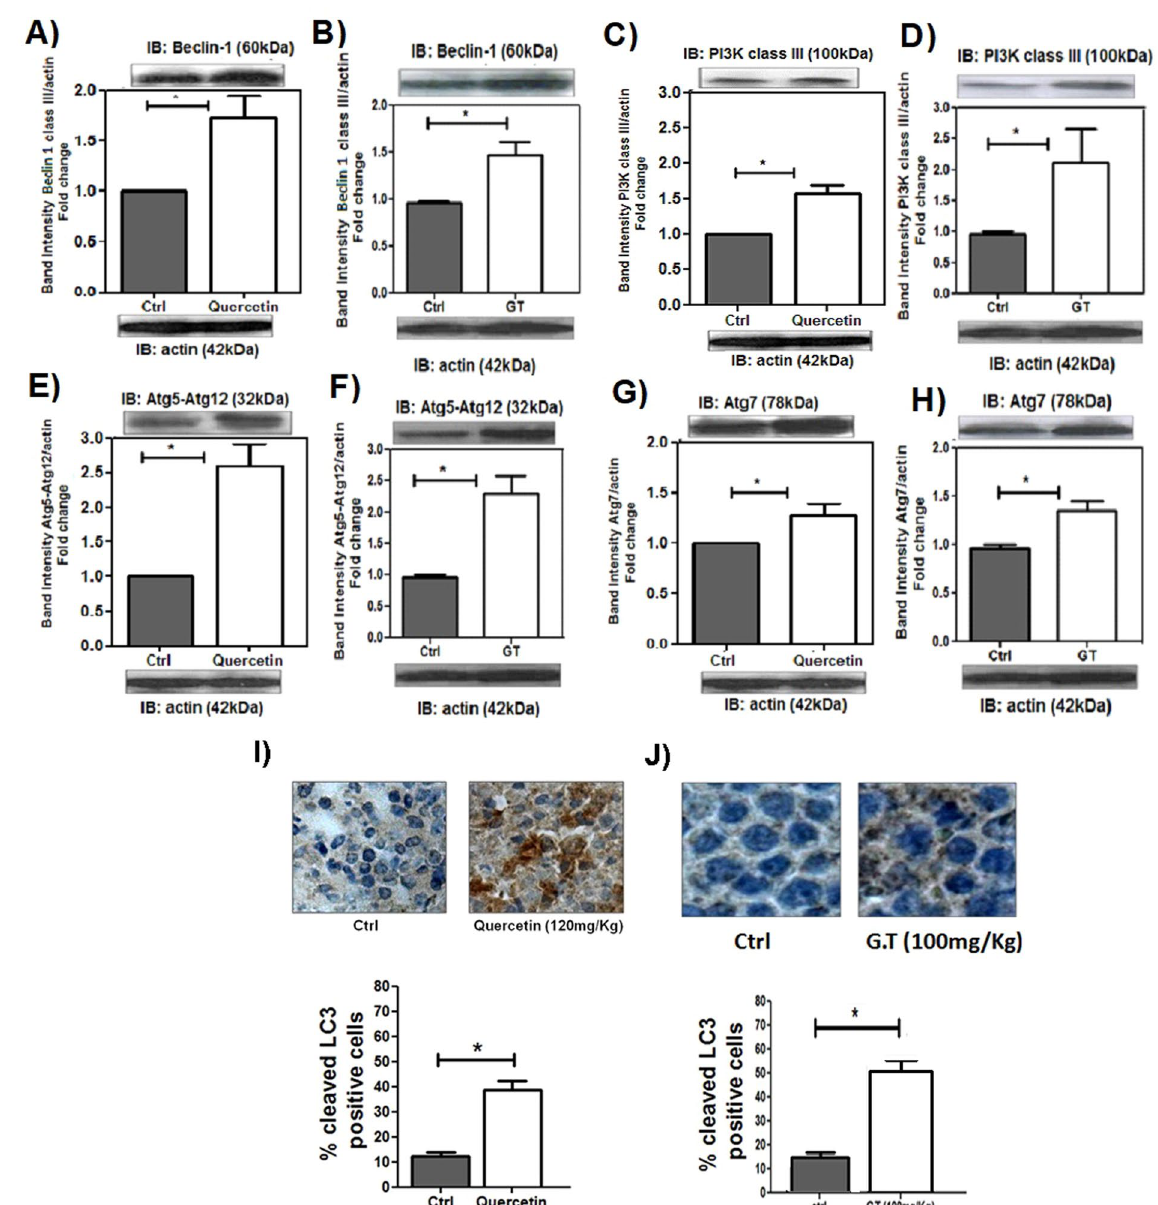
Figure 4. Quercetin and Green Tea induce autophagy in HL60 xenografts. NOD/SCID mice with HL60 tumors were treated or not with quercetin (120 mg/kg), once every 4 days or green tea (100 mg/kg), every day. After 3 weeks, tumors were harvested and relative levels of protein in tumor lysates were determined by Western blotting; ( A , B ) BECLIN-1; ( C , D ) PI3K; ( E , F ) ATG5-ATG12; ( G , H ) ATG7; ( I , J ) IHC analysis of cleaved LC3 in tumor sections and the percentage of LC3-positive nuclei of cells per field; four fields per tumor section. Counts were performed using x40 objective connected to a light microscope (Olympus CBA; Olympus America). Values are means ± SD (mean of 6 mice/group); * P <